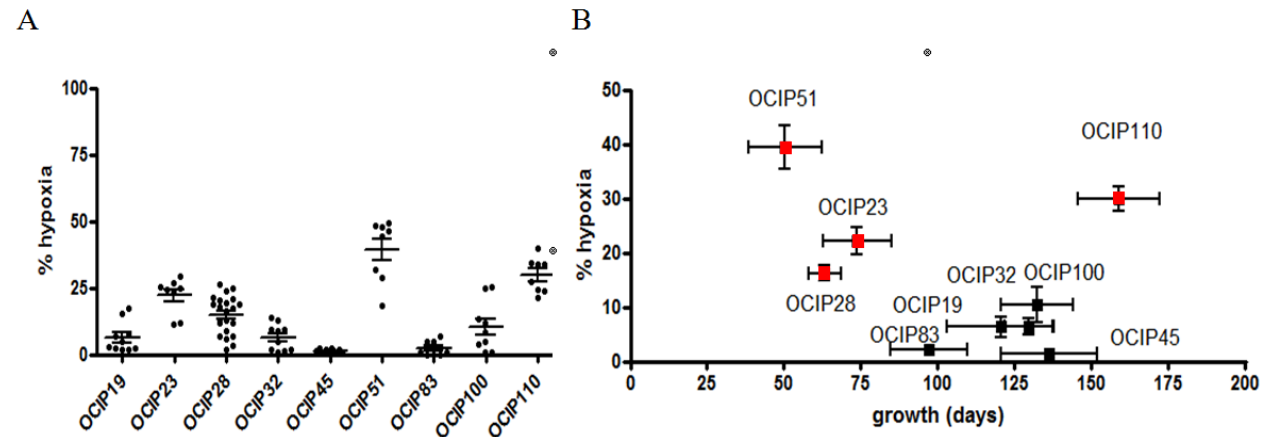
Figure 1. Patient-derived pancreatic xenograft models differ in the magnitude of tumor hypoxia and metastatic potential. ( A ) Percentage of tumor hypoxia as indicated by EF5 staining of the patient-derived xenograft models. Each point represents the hypoxia status in a single tumor. The xenograft models display a wide range of tumor hypoxia that remains similar over several passages in vivo ; ( B ) EF5 staining vs. tumour growth shows that hypoxia mostly correlates with rapid growth pattern. Tumor growth is defined by the time elapsed between two passages. Metastatic models are labelled in red. Representative sections of ( C ) OCIP19, ( D ) OCIP23 and ( E ) OCIP51 stained for EF5. Tumor hypoxia in all models is found in both the tumor and tumor-associated